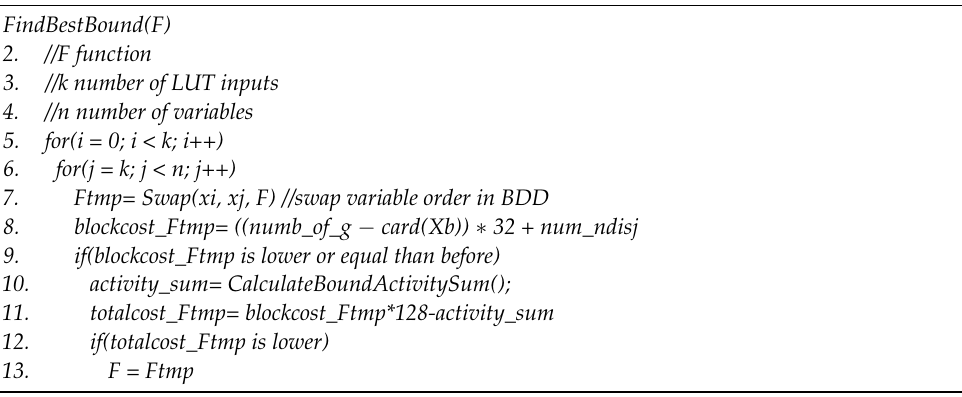
Algorithm 1. The Algorithm for Searching for the Best Set of Variables for Bound